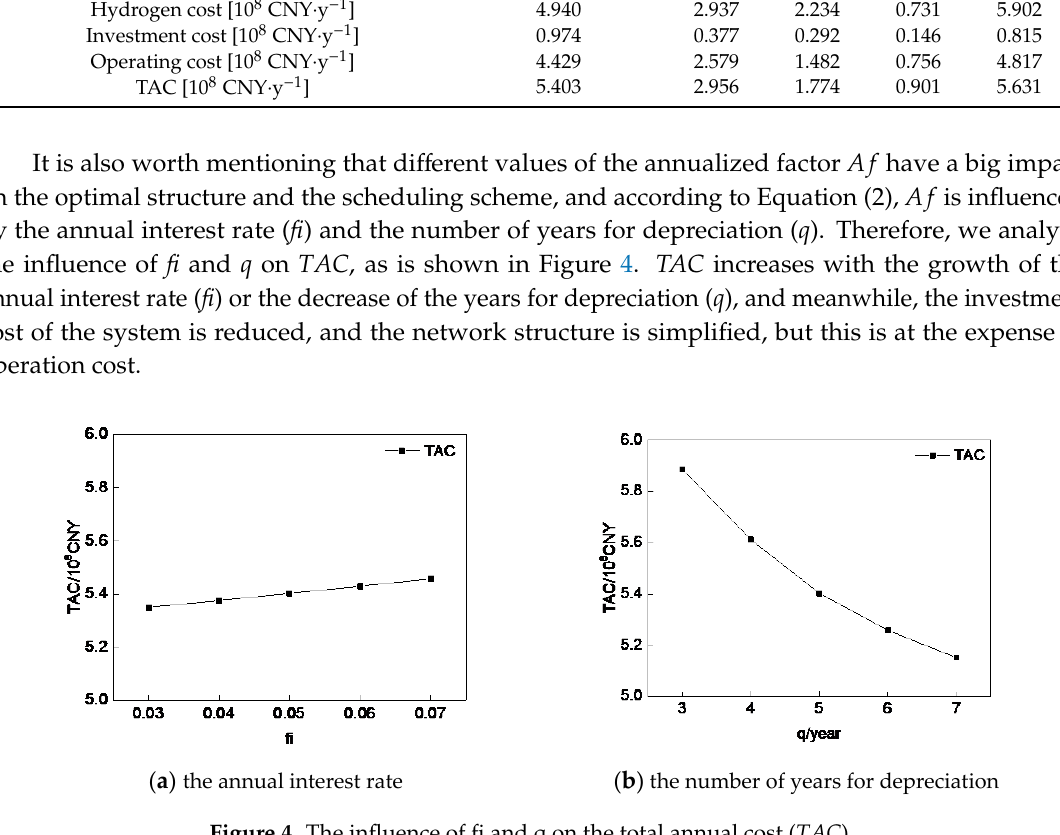
Table 3. Comparison of the inter-plant integration and individual plant integration.